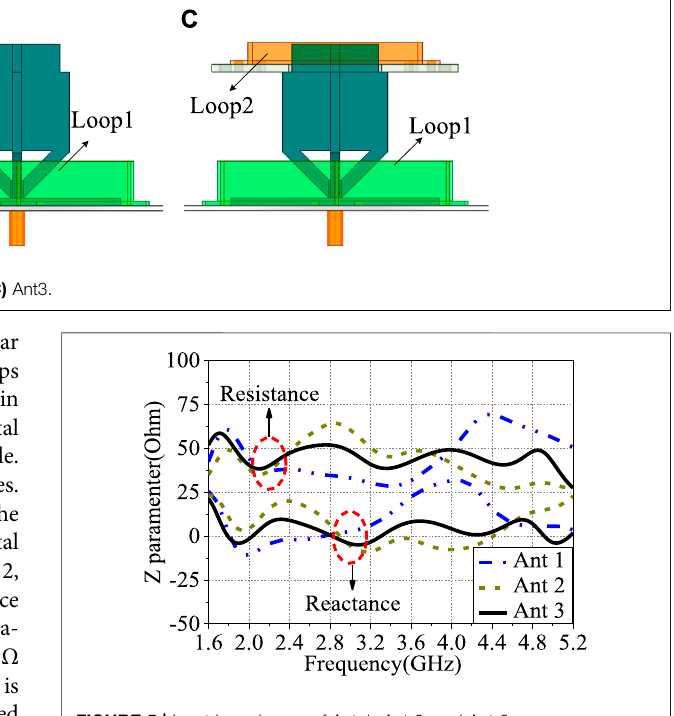
FIGURE 5 | Input impedances of Ant 1, Ant 2, and Ant